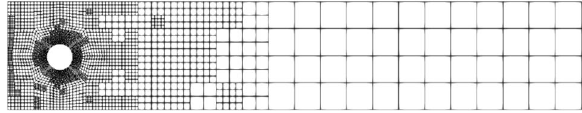
Fig. 2 Sketch of the domain and boundaries for the flow bench- mark